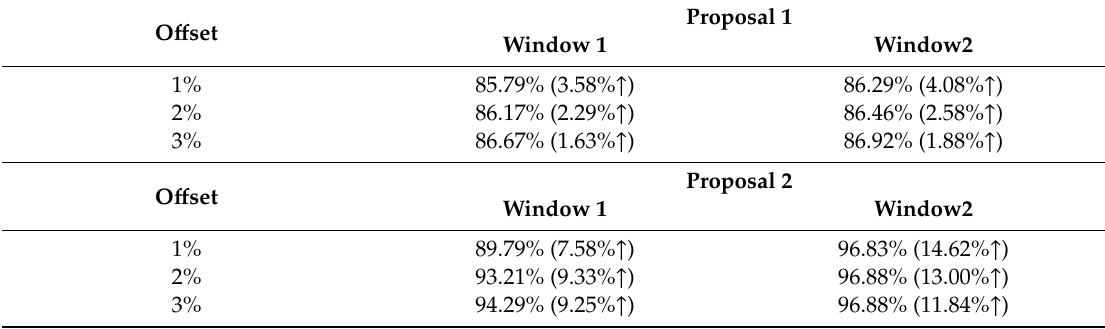
Table 8. Detection probability of methods.